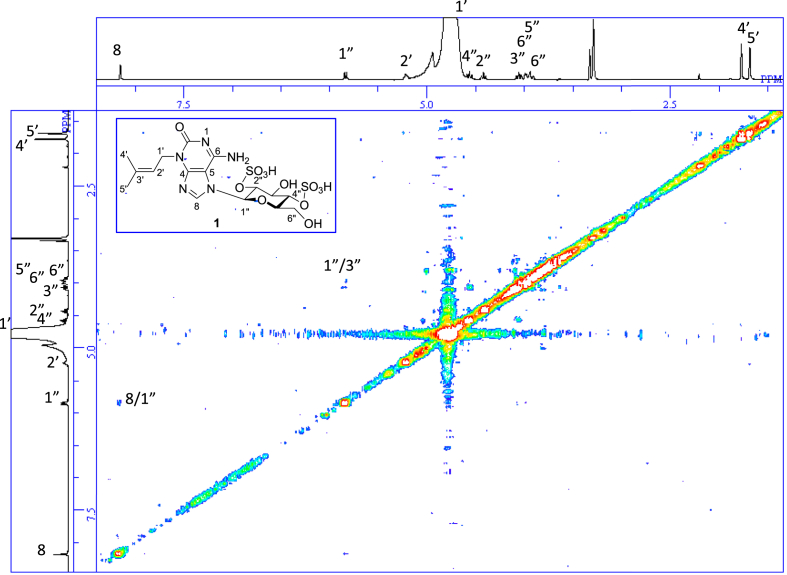
1H–1H NOESY of 1.